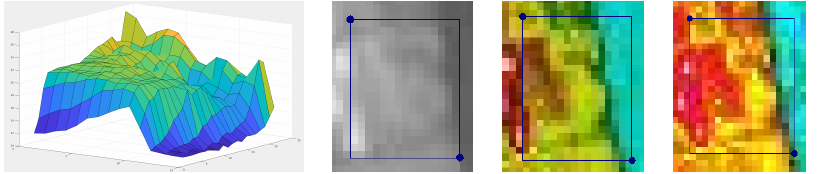
Figure 11. Bad quality image of a partially shaded PV module. From left to right: temperature distribution, grayscale image, RHC image, RHC + CLAHE